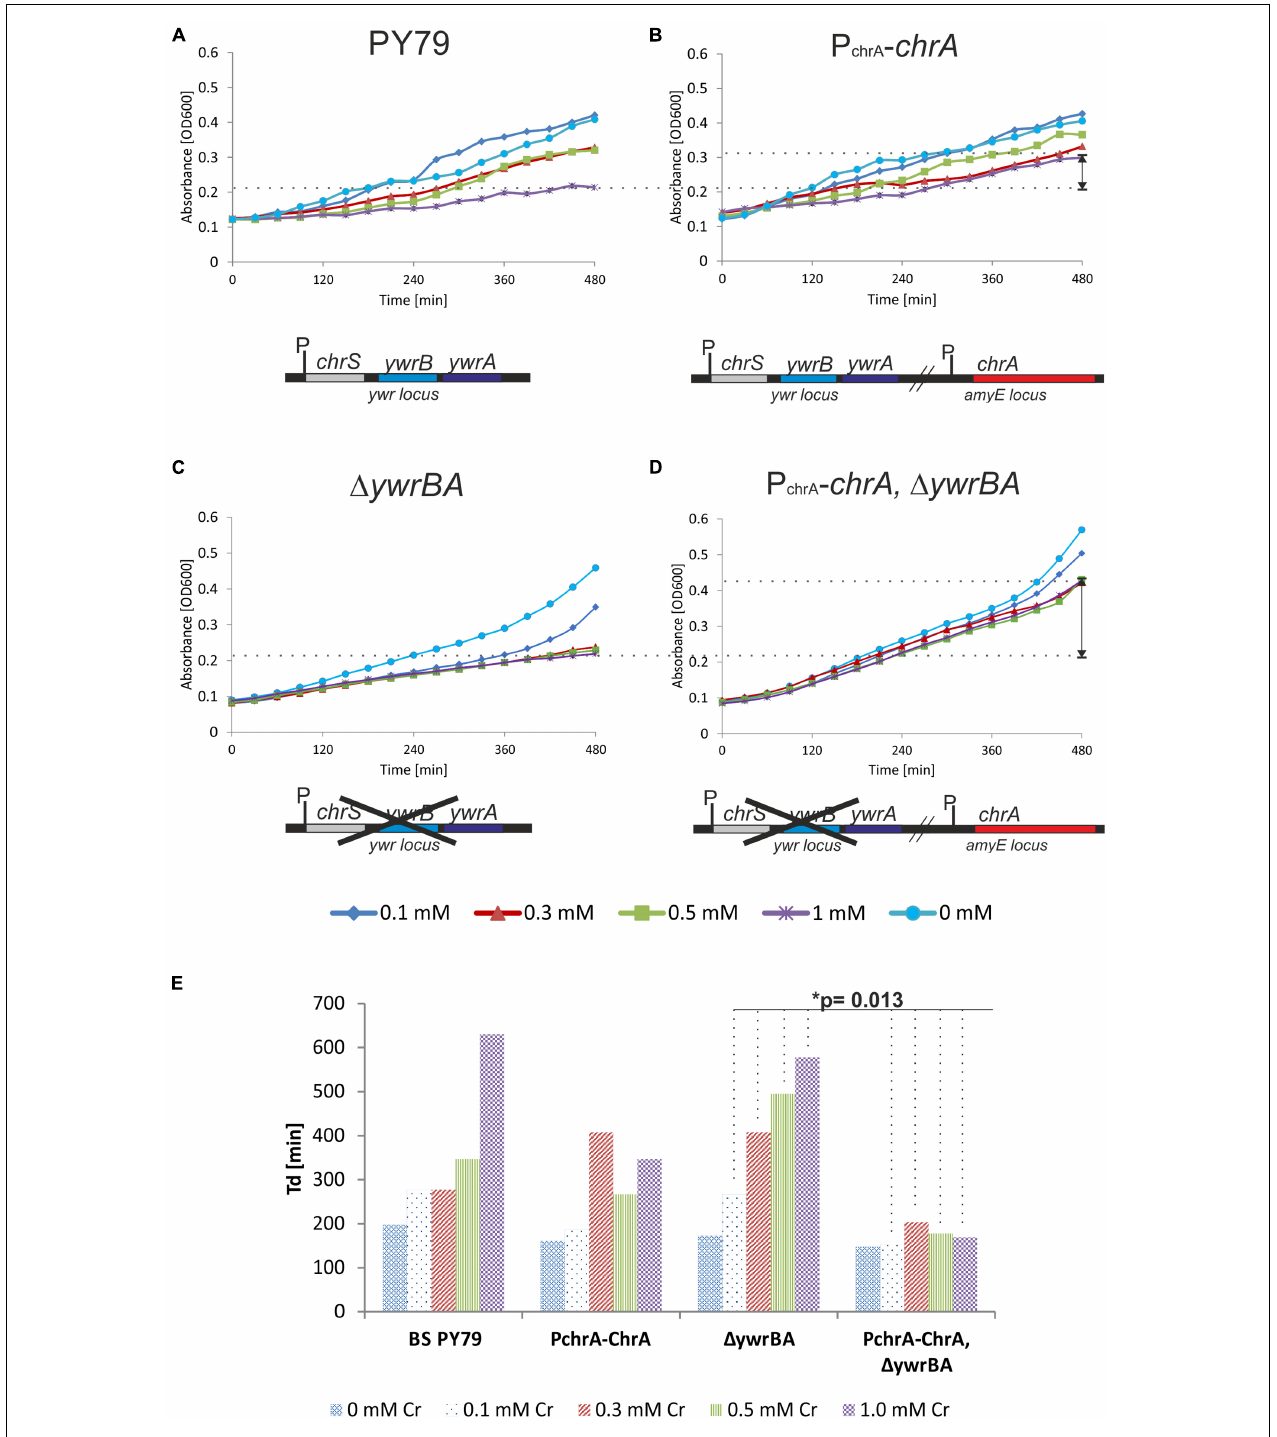
FIGURE 3 | Growth of PY79 and B. subtilis recombinant strains affected by Cr(VI) stress. (A–D) The growth of strains recorded as OD600 values over time. Under each chart is a diagram of the genetic background of the strain analyzed. The legend at the bottom indicates the Cr(VI) concentration. (A) The growth of the reference strain PY79 under Cr stress. This strain harbors two original Cr transporters ywrB and ywrA . (B) The growth of the P chrA - chrA strain. This strain harbors a copy of chrA from NCr1a strain under control of its own P chrA promoter at amyE locus, in addition to the original Cr transporter ywrBA locus of B. subtilis. (C) The growth of the (cid:49) ywrBA B. subtilis strain. This strain has no Cr transporters. (D) The growth of the P chrA - chrA (cid:49) ywrBA strain. This strain expresses chrA under control of P chrA from amyE locus, in (cid:49) ywrBA background. (E) Comparison of the doubling time (T d ) of B. subtilis strains affected by different levels of Cr stress. The significance of differences was confirmed by Two-way Anova testing. The shortest T d was associated with the P chrA - chrA (cid:49) ywrBA genotype.